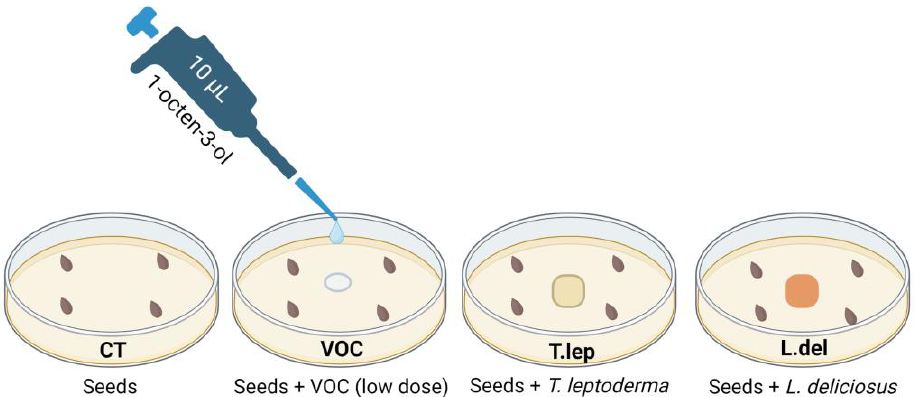
Figure 1. Experimental design to evaluate the effect of 1-octen-3-ol and ECM mycelium on Cistaceae species germination (N = 5).